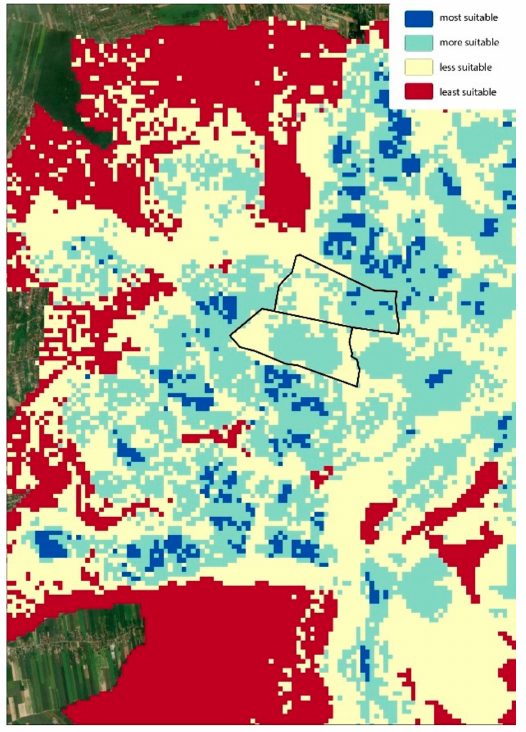
Figure A4. Lublin’s preselected and candidate areas to become